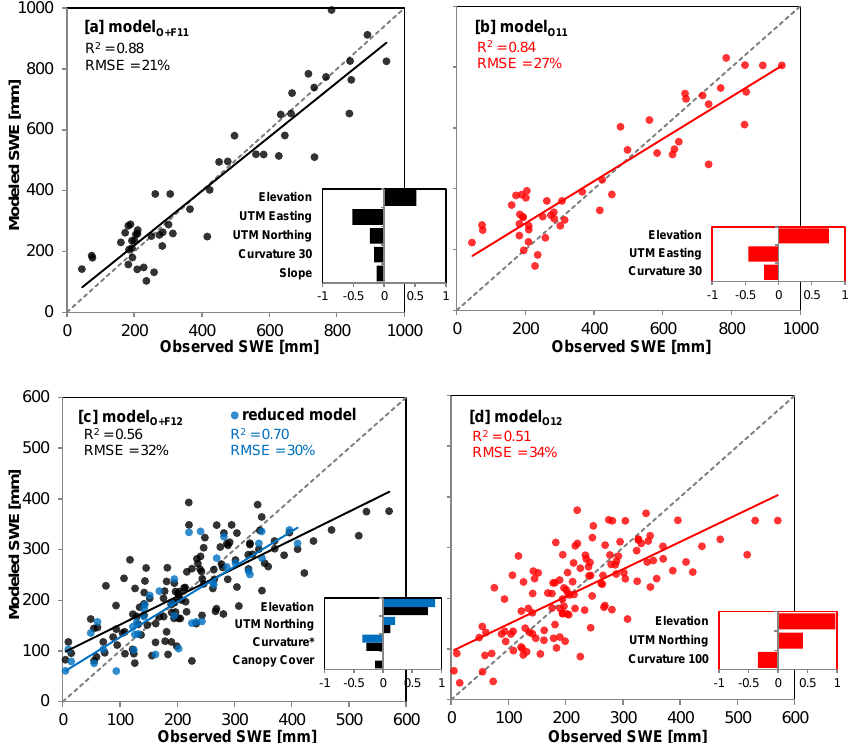
Fig. 6. Scatterplots showing observed versus modeled SWE from model O + F (shown in black) and model O (shown in red) for both WY 2011 and 2012. The observed values used to evaluate each model include the combined operational and field-based data set. The reduced model O + F12 includes only field-based measurement locations also sampled during WY 2011 (shown in blue). The callout bar graphs show the relative influence of each model coefficient (beta coefficients). Curvature* represents curvature 100 for model O + F12 and curvature 30 for the reduced